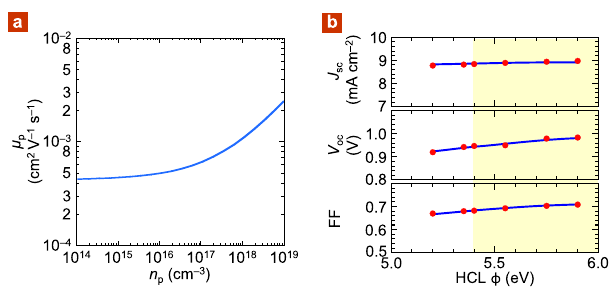
Fig. 6 Simulation results. a Hole-mobility simulation, from Gaussian disorder theory: μ p = μ o , p (1 + α ( n p / N site ) 0.50 ), where n p is hole density, μ o , p is limiting hole mobility at low density, α is hole-density coef fi cient, and N site is transport site density. For parameter values, see caption of Table 1. experiment from Fig.